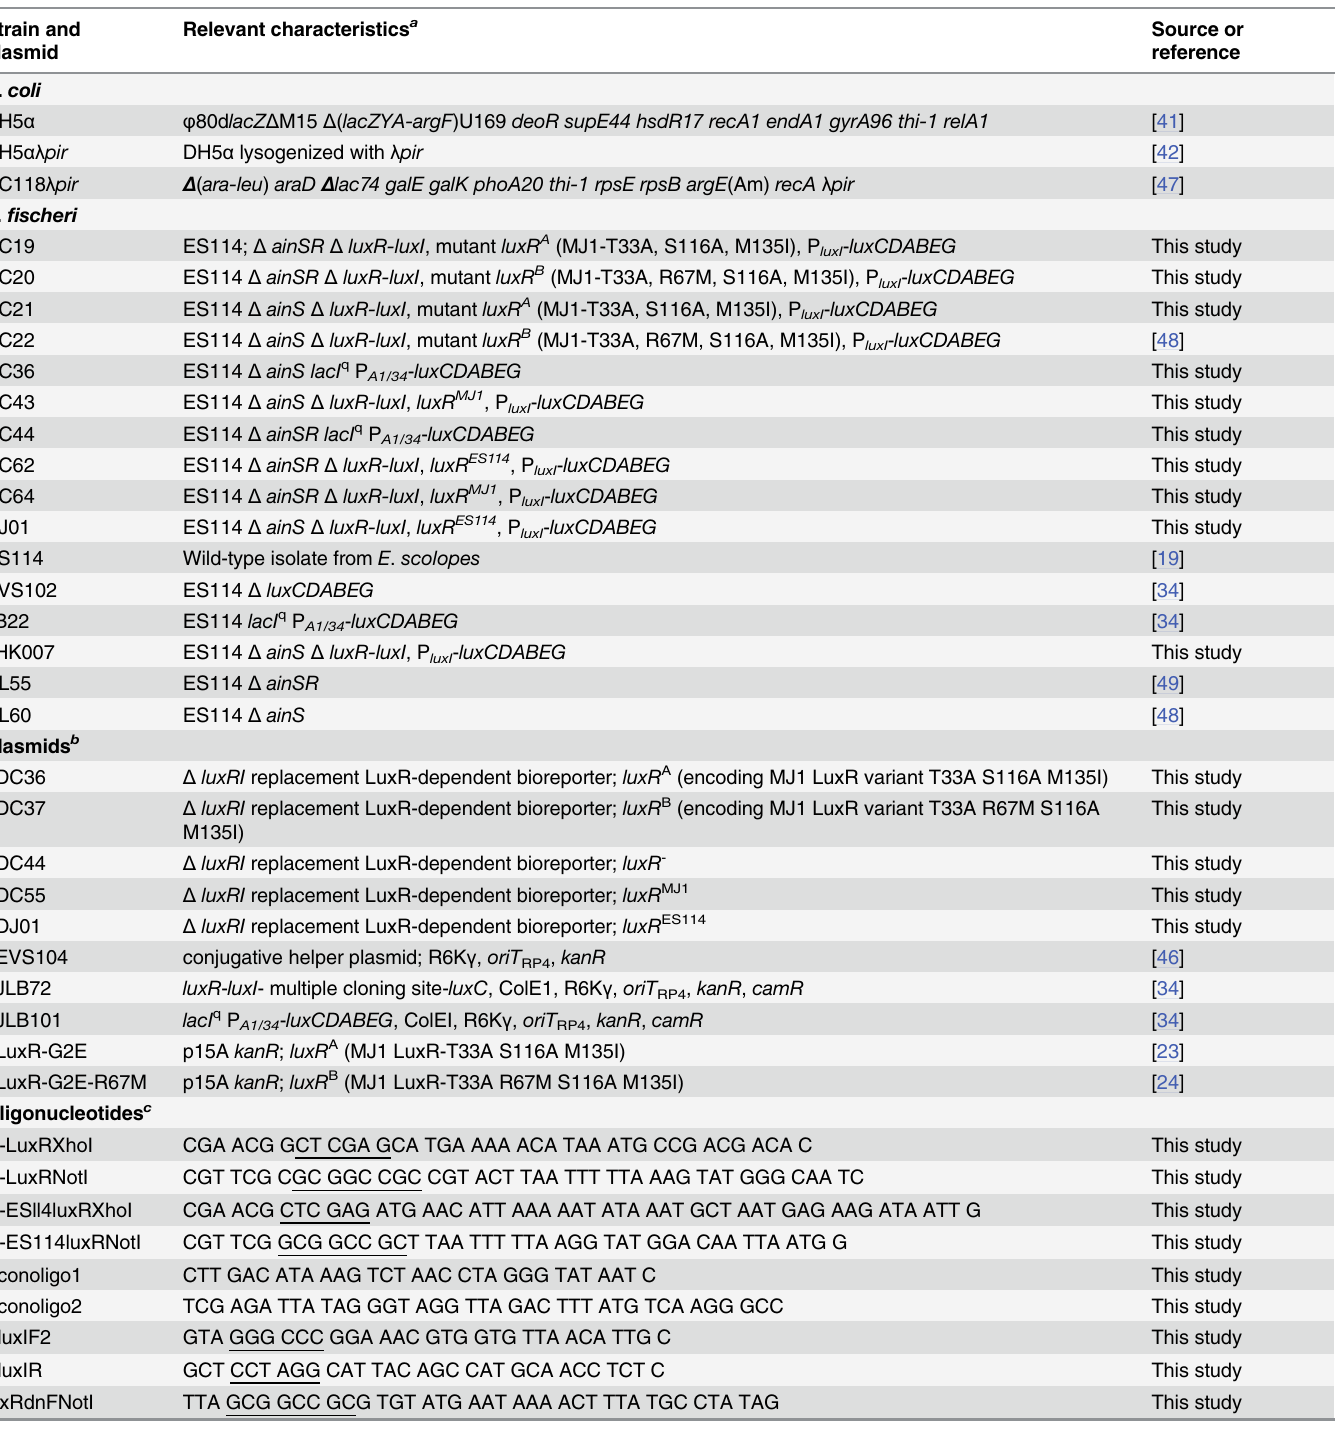
Table 1. Bacterial strains and plasmids used in this study. Strain and